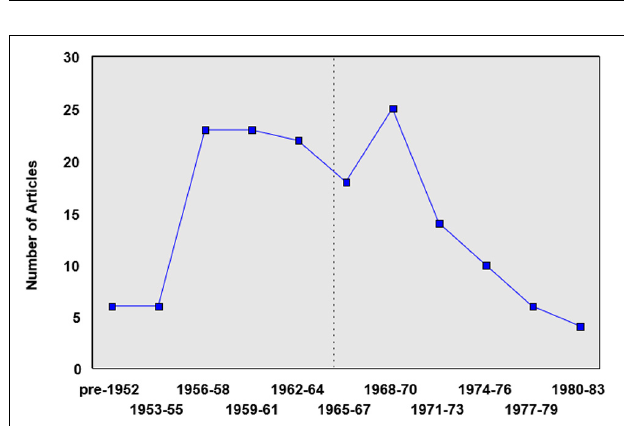
FIGURE 2 | Frequency of articles published on strontium in the biochemical literature,